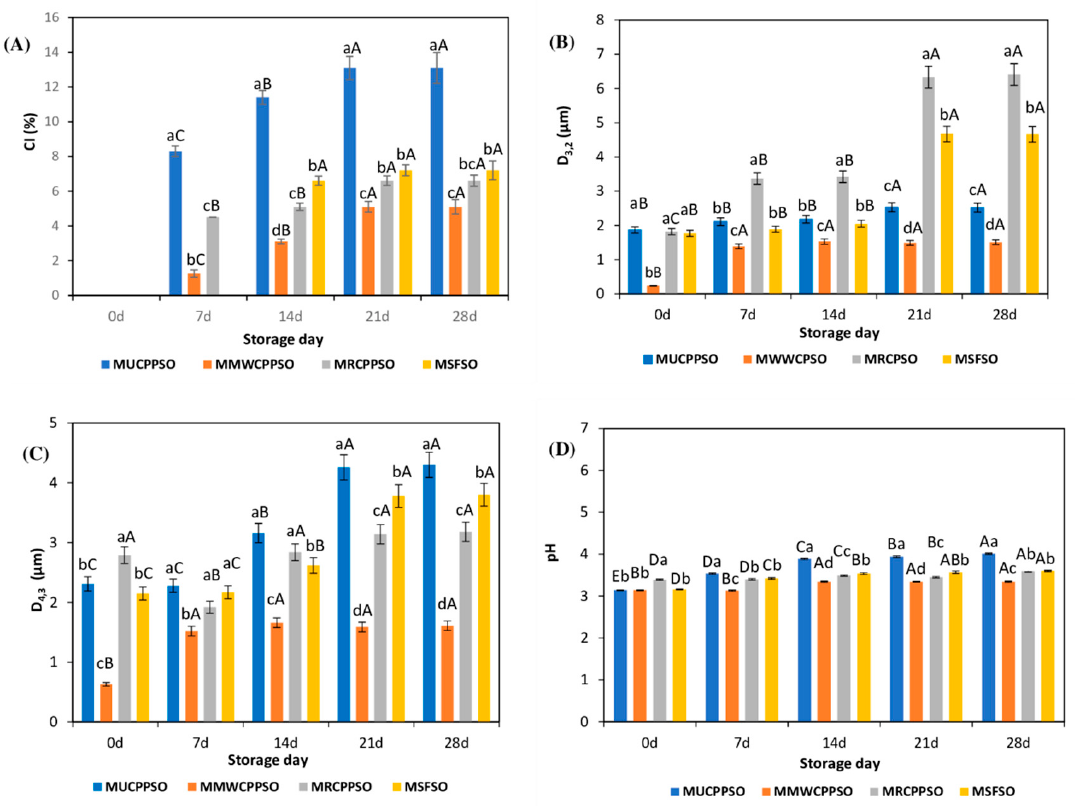
Figure 2. Evolution of the CI (%) ( A ), D 3,2 ( µ m) ( B ), D 4,3 ( µ m) ( C ), and pH values ( D ) of the mayonnaises during storage. Values are means ± standard deviations (SD) of three independent determinations. Different lowercase letters represent significant differences between the mayonnaises ( p < 0.05). Different uppercase letters represent significant differences between storage times of each mayonnaise ( p < 0.05).